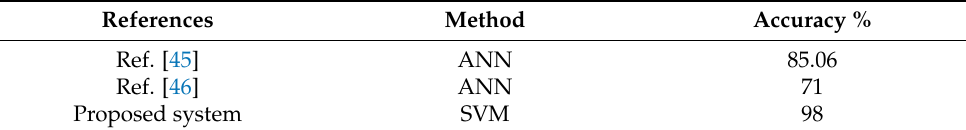
Table 7. Comparison of results and those of previous systems.